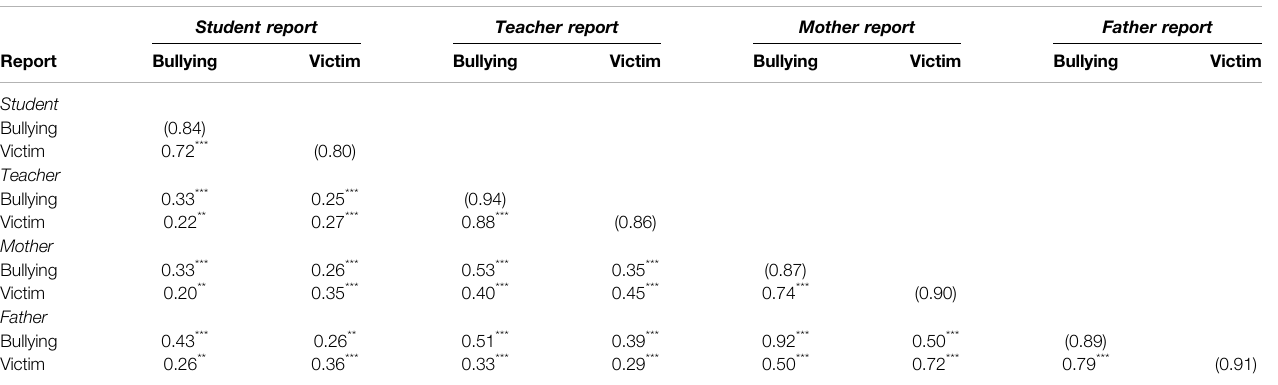
TABLE 6 | Correlations in the CCFA MTMM model of the latent factors and internal